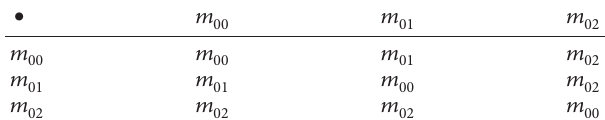
( k ) P ( m ) is given. λ p d t d t d t